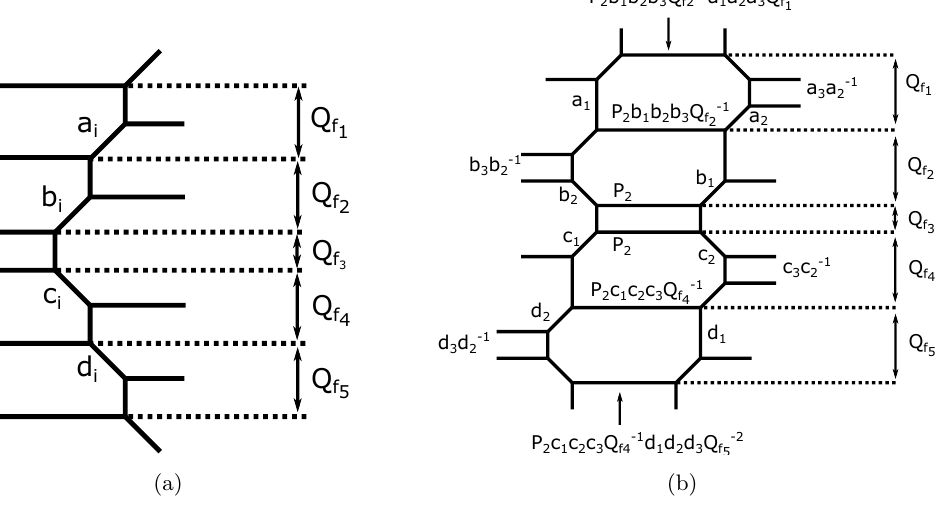
Figure 35. (a). Local geometry near the SU(6) part of each quiver tail of the affine E 6 Dynkin quiver theory. (b). Local geometry which describes the SU(6) 0 gauge theory with 12